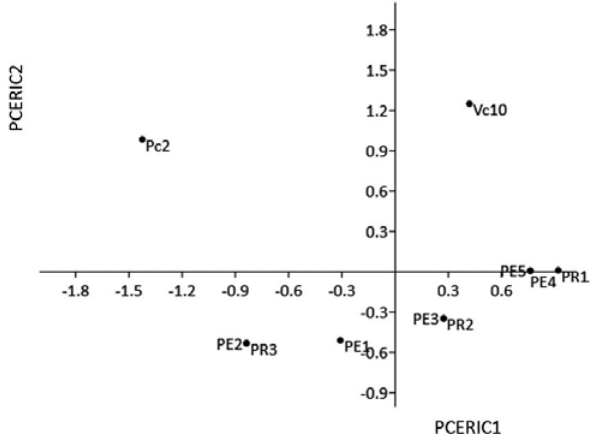
Figure 4. Principal Component Analysis of Enterobacterial Repeti- tive Intergenus Consensus sequence (ERIC) PCR profiles obtained from Pochonia chlamydosporia isolates (PE1, PE2, PE3, PE4, PE5, PR1, PR2, PR3, Pc2 and Vc10; refer to Table 1 for isolate informa- tion). PCERIC1 eigen value 0.651; PCERIC2 eigen value 0.400.